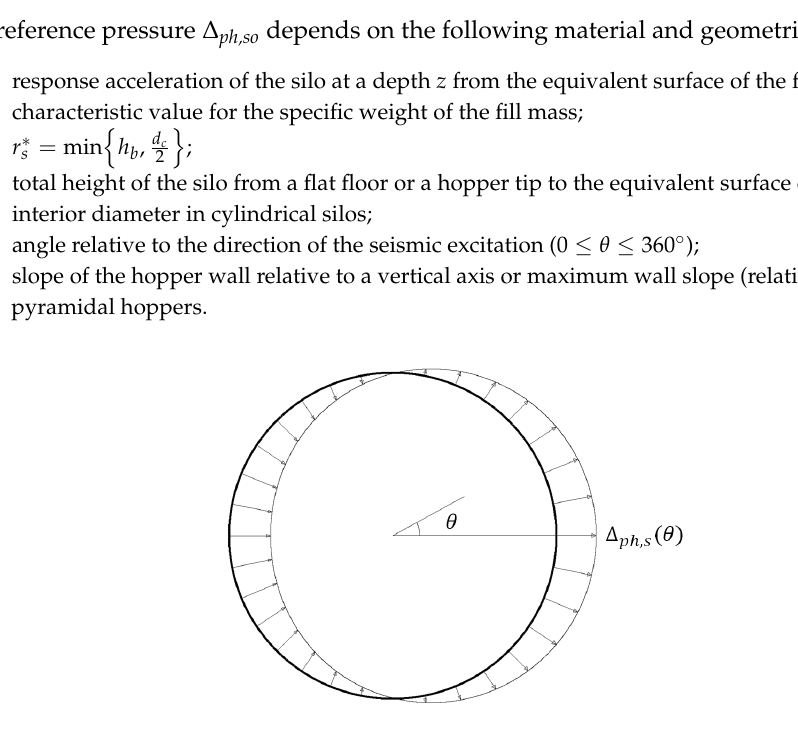
Figure 2. Equivalent static load for cylindrical silos according to Eurocode 8, Part 4 [11].